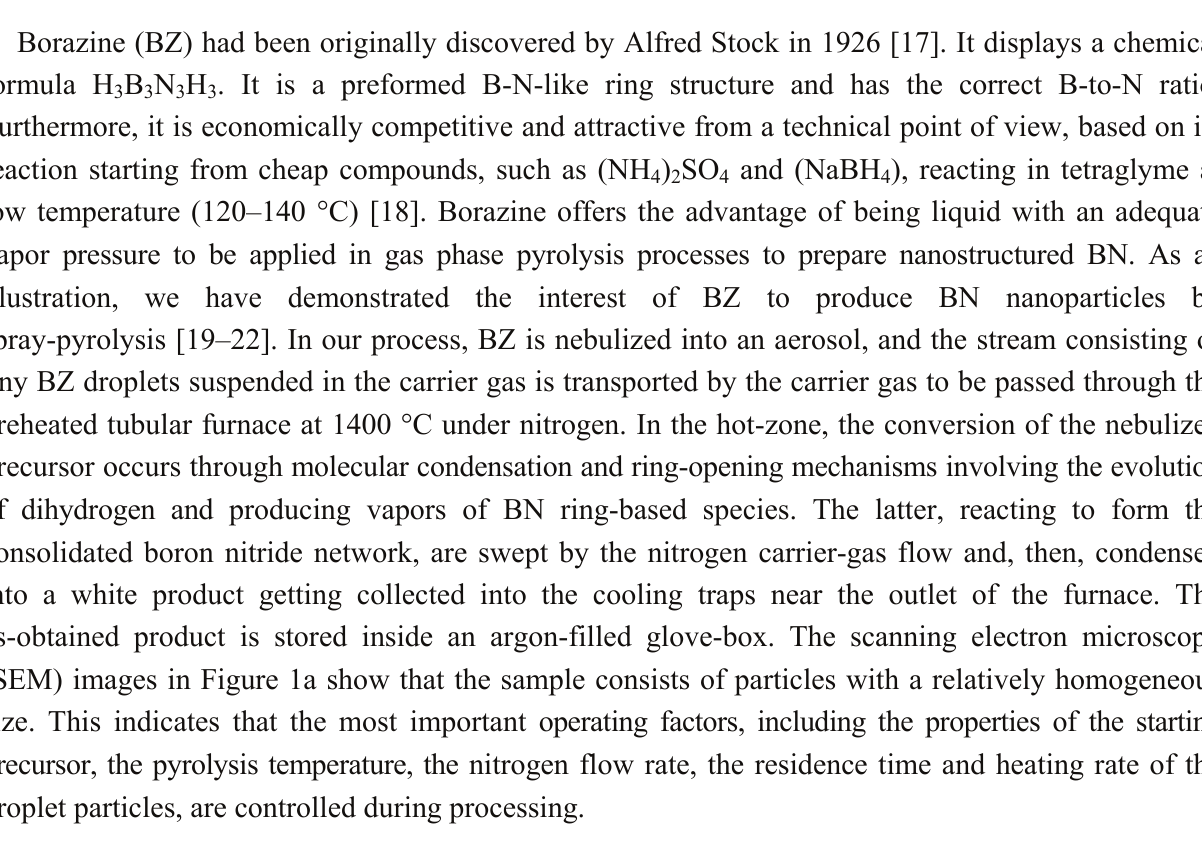
Figure 1. SEM ( a ), TEM ( b ) and HRTEM ( c ) images of samples obtained by spray-pyrolysis of borazine